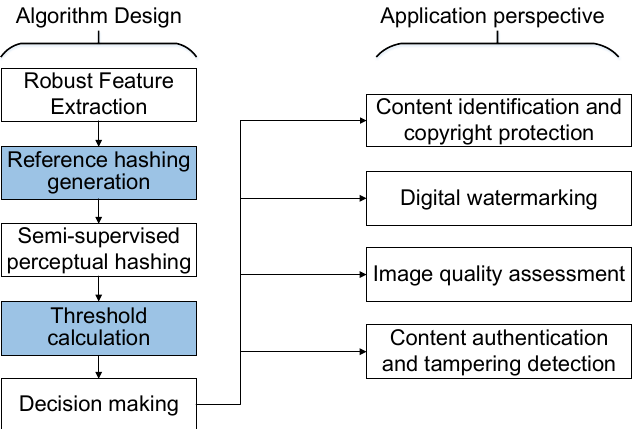
Figure 6. A generic framework of image hashing and an application